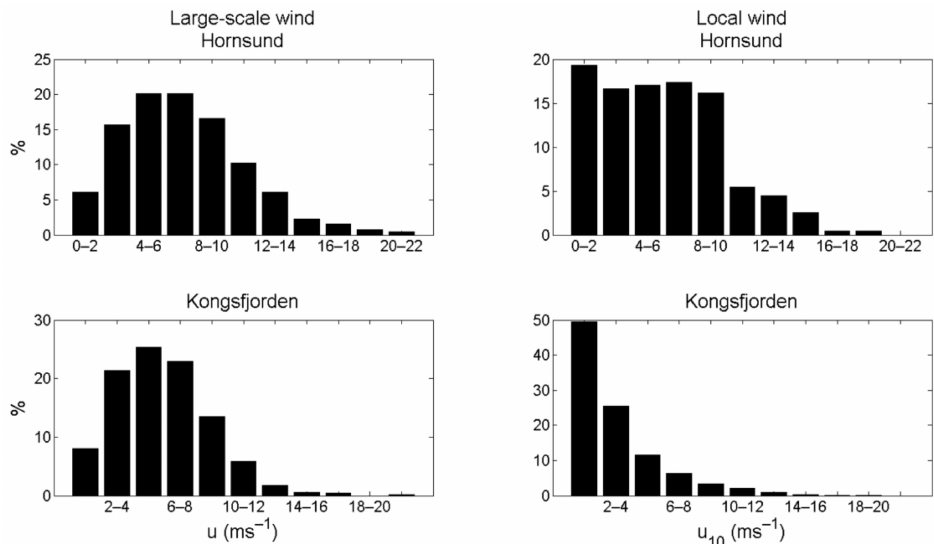
Figure 11. The distribution of large-scale wind speed from the NCEP/NCAR reanalysis and local wind speed from stations in Hornsund and Ny-Ålesund when the mesoscale factor visibly dominated the large-scale one, but with temperature over open water being lower than over land between 1994 and